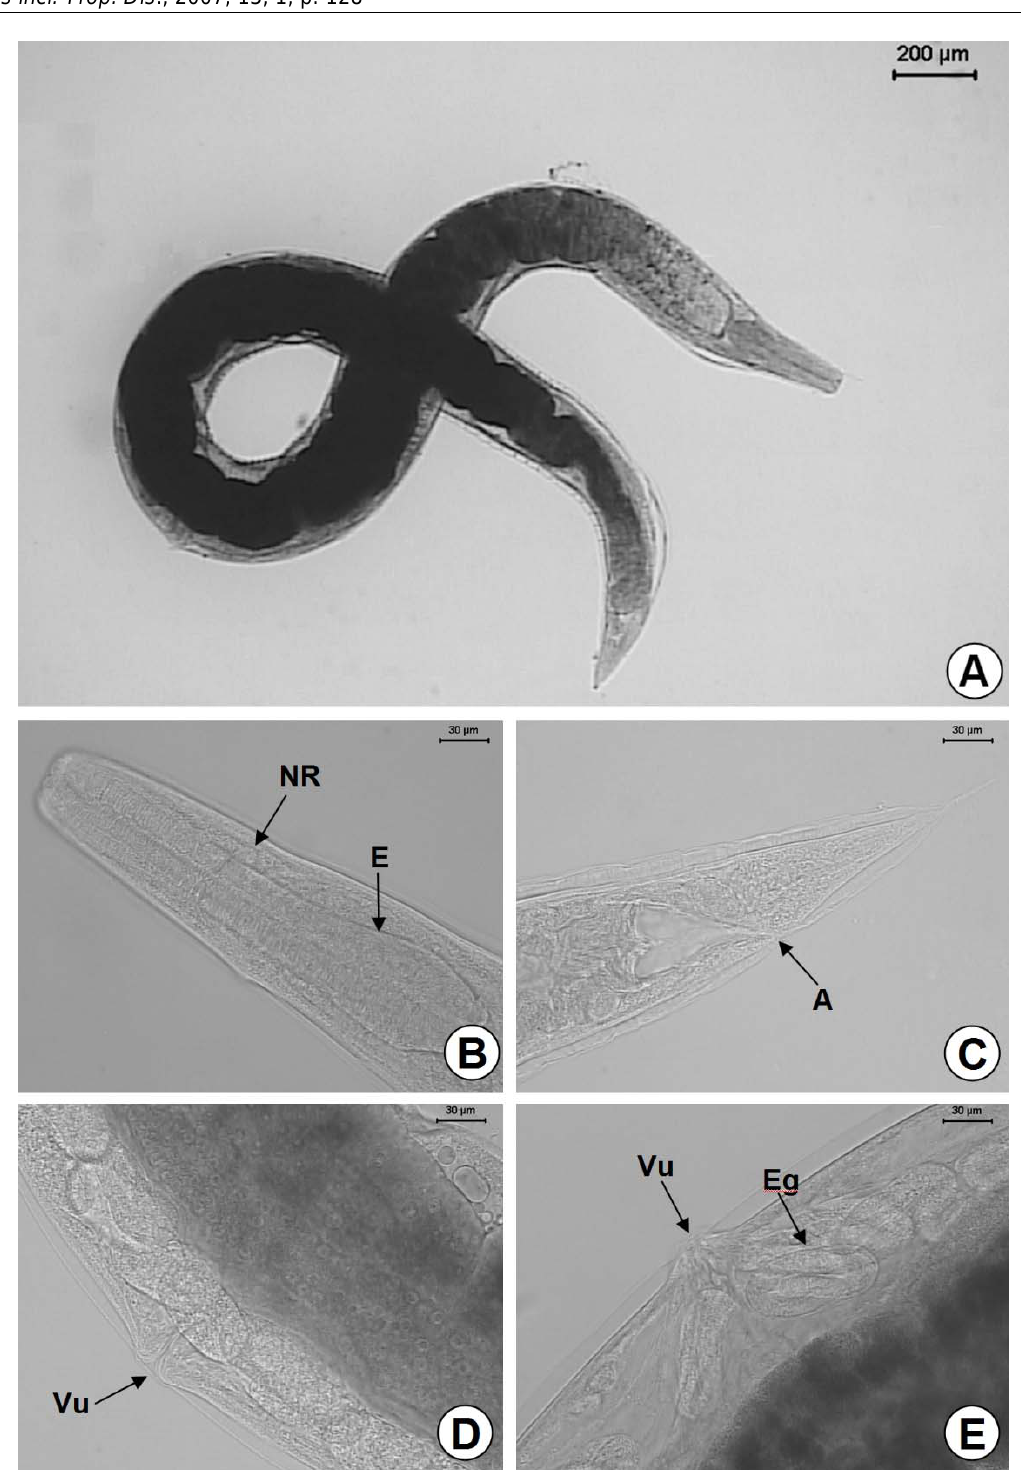
Figure 1. Rhabdias sp. from Crotalus durissus terrificus lung. A) General view of the partenogenetic female; B) Detail of the esophagus (E) and nerve ring (NR); C) Anus (A); D) Vulva (Vu); E) Larval egg (Eg) inside the